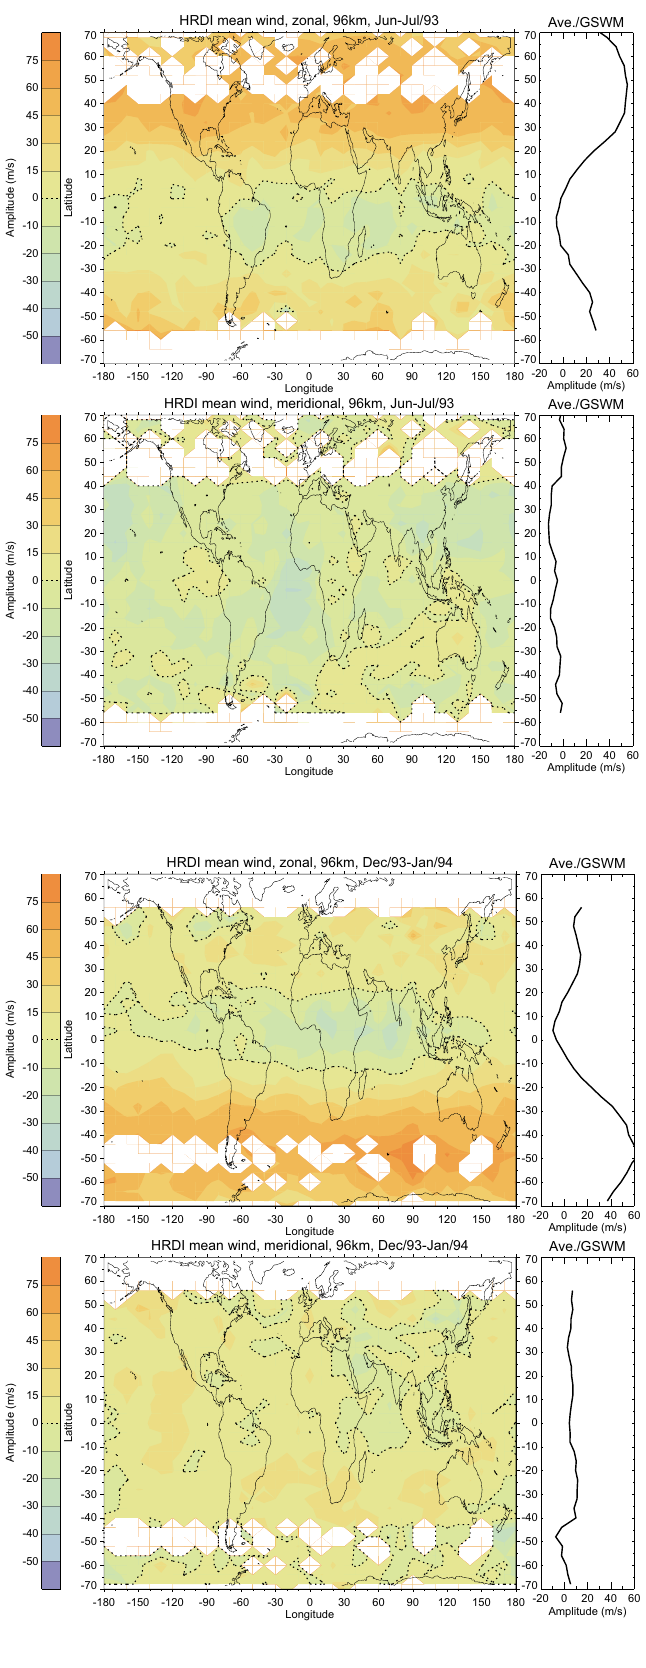
Fig. 12. Mean winds at 96km for December 1993–January